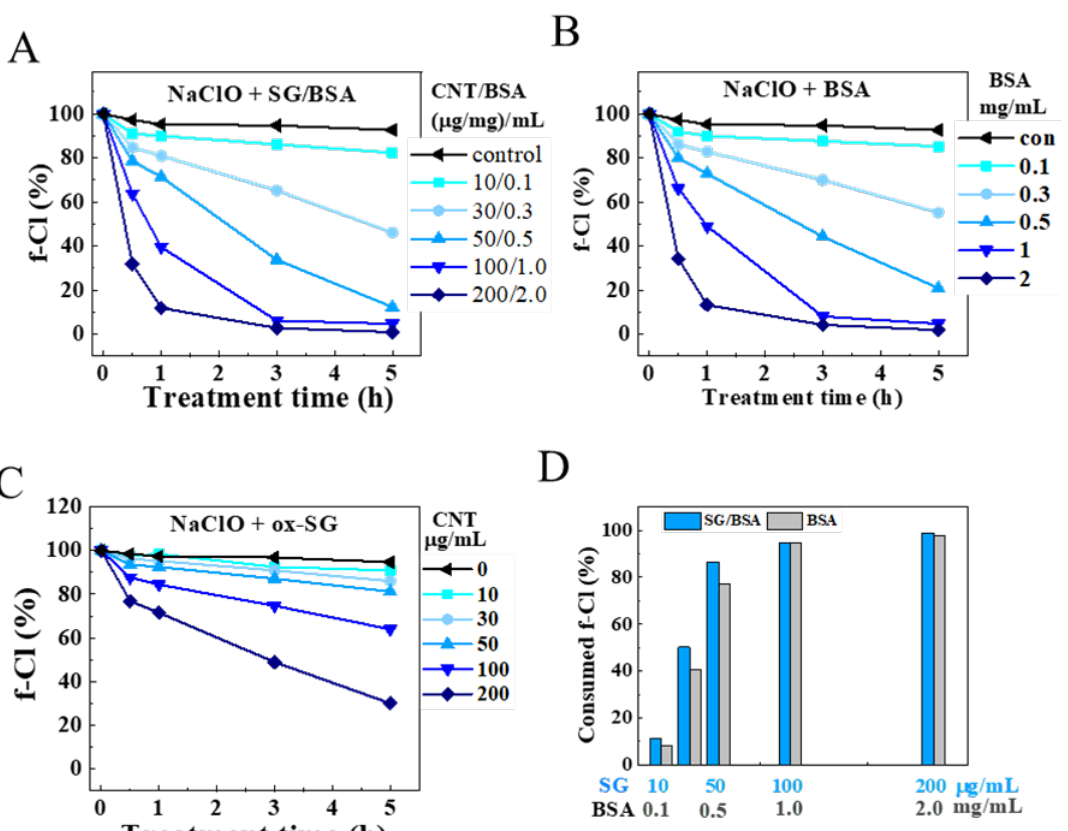
Figure 6. The amounts of free available chlorine (f-Cl) remaining in NaClO solutions (2.26 wt%) after 0 – 5 h incubation at 70 °C. ( A ) for SG/BS, in which the concentrations of CNTs/BSA were 10/0.1, 30/0.3, 50/0.5, 100/0.1. and 200/0.2 (µg/mg)/mL; ( B ) for BSA at concentrations of 0.1 – 2 mg/mL; and ( C ) for ox-SG at CNT-concentrations of 0 – 200 µg/mL. The total amounts of consumed f-Cl after five hours for SG/BSA (blue) at CNT-concentrations of 10 – 200 µg/mL and BSA only (grey) are shown ( D ). The concentrations of BSA in the SG-BSA samples (blue) were the same as those in the BSA samples (grey). SG/BSA dispersions were obtained by dispersing SG-CNTs in BSA solution (CNTs: 0 – 200 µg/mL; BSA: 0 – 2.0 mg/mL).